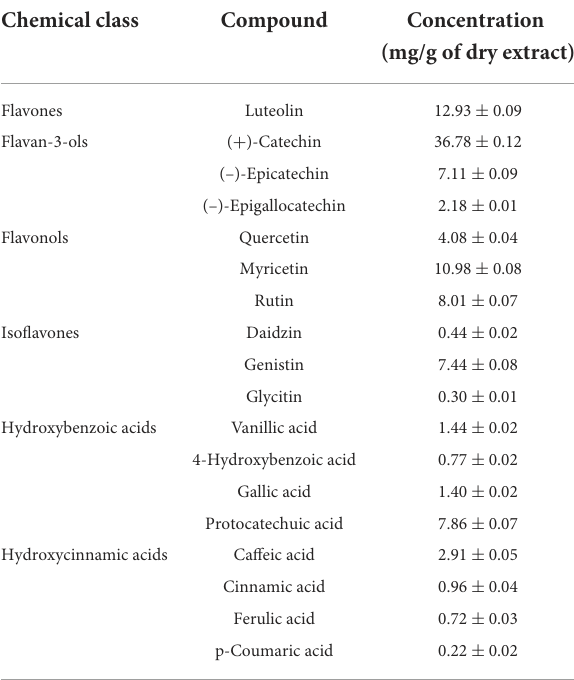
TABLE 1 Quantification of phenols in obtained walnut leaf